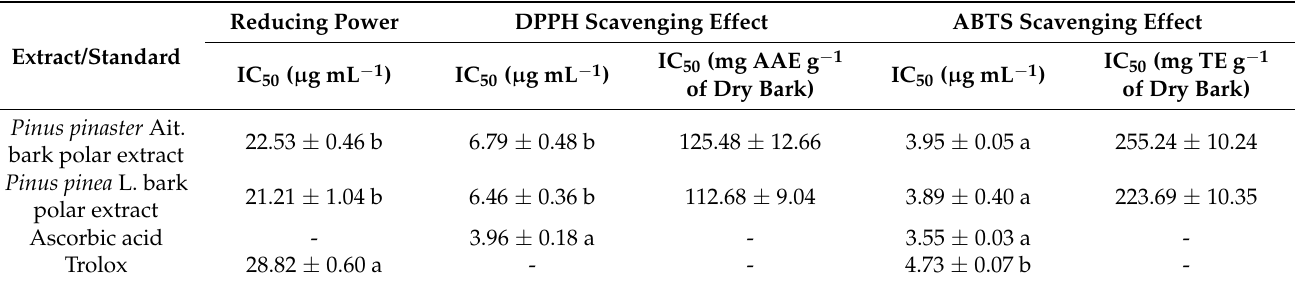
Table 5. Antioxidant activity of Pinus pinaster Ait. and Pinus pinea L. bark polar extracts, through reducing power, DPPH, and ABTS scavenging